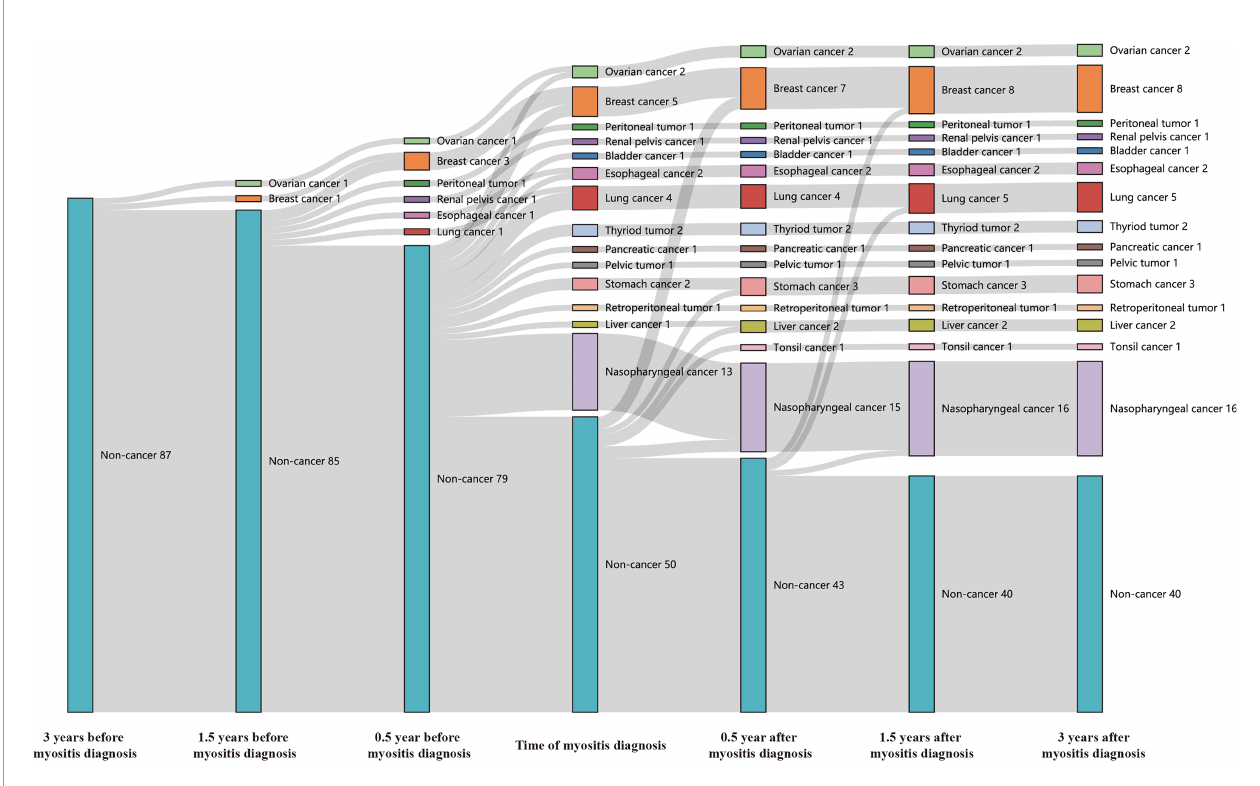
FIGURE 1 | The Sankey diagram showed temporal relationships between the diagnosis of myositis and cancer in 87 anti-TIF1 g + myositis patients. Seven time points, including 0.5, 1.5, and 3 years before or after myositis diagnosis and the time of the myositis diagnosis, were